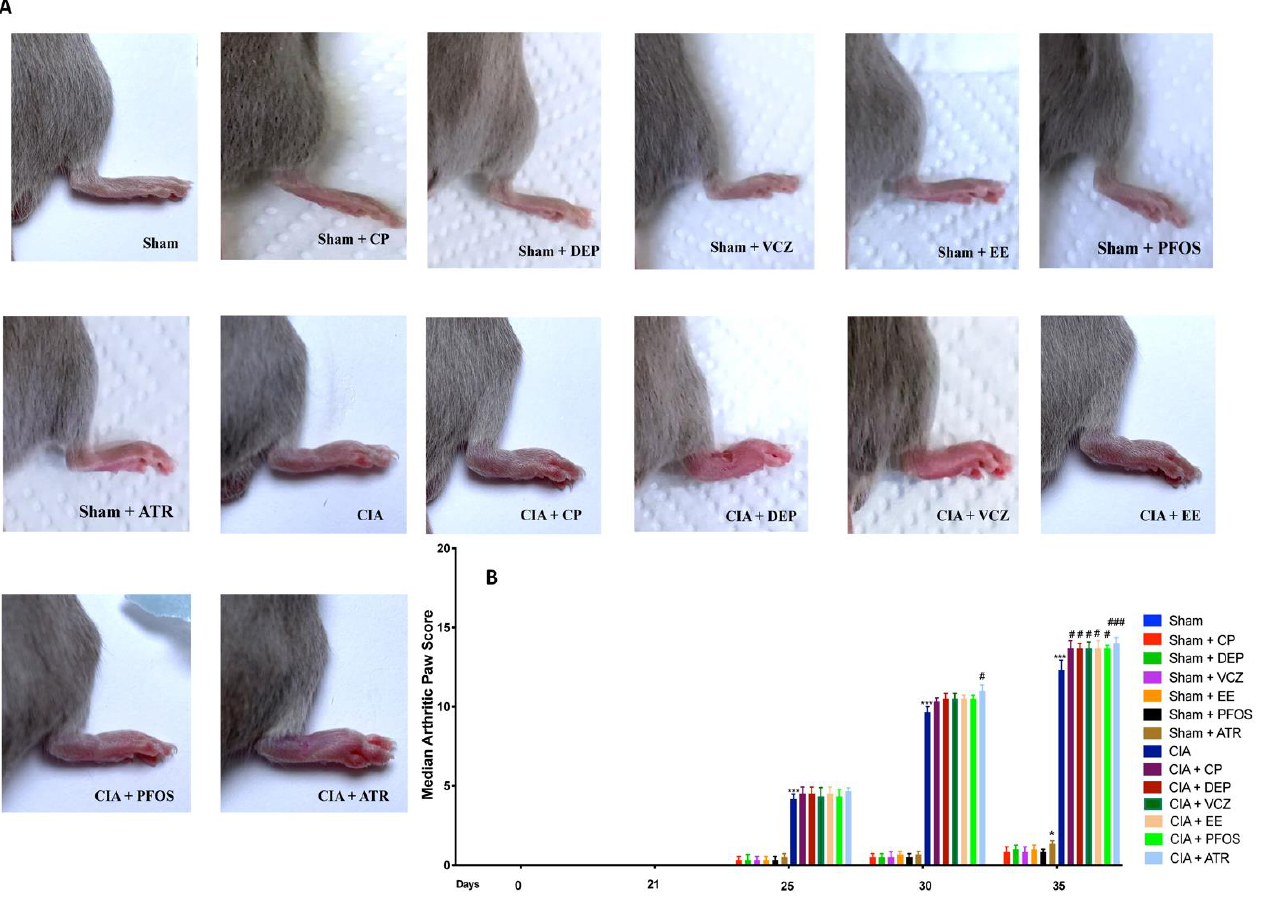
Figure 2. Macroscopical analysis of paw from all groups ( A ); median arthritic paw score at days 0, # p < 0.05 vs. CIA; ### p < 0.001 vs. 21, 25, 30, 35 ( B ). * p < 0.05 vs. sham; *** p < 0.001 vs. sham; # p < 0.05 vs. CIA; ### p < 0.001 vs. CIA. 25, 30, 35 ( B ). * p < 0.05 vs. sham; *** p < 0.001 vs. sham;